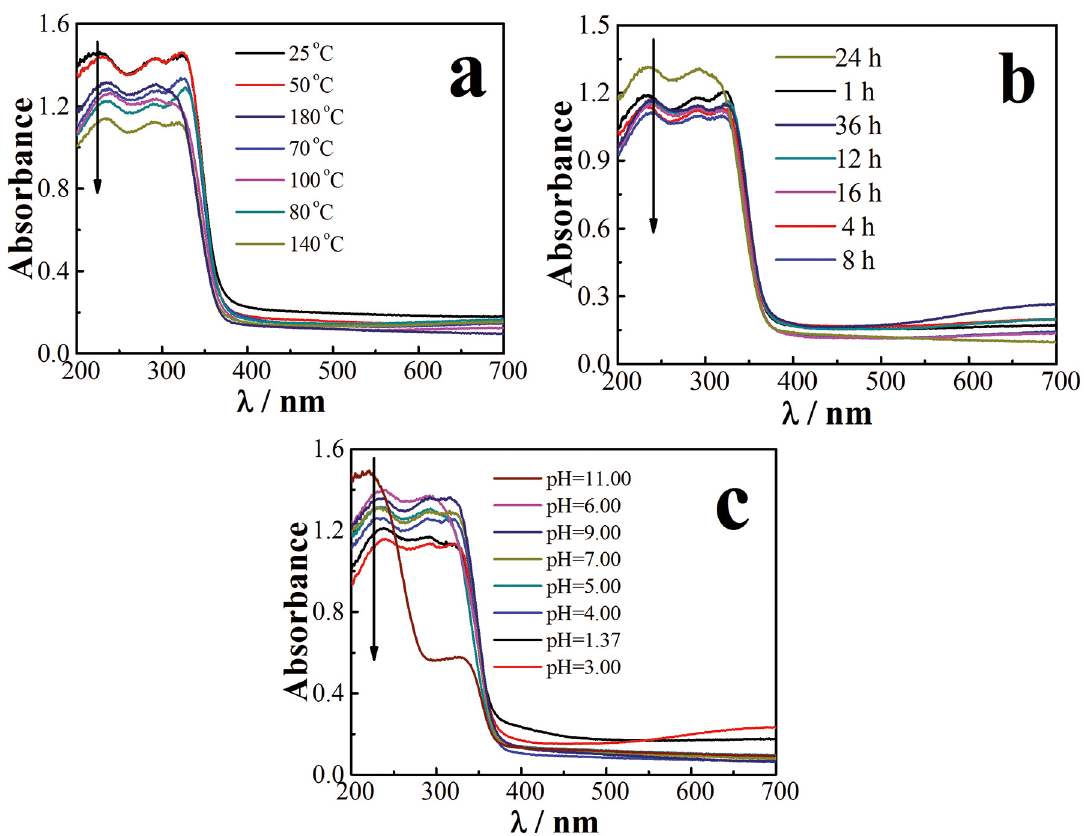
products. (a) temperature series at pH=5 for 24 h, (b) time series at 4